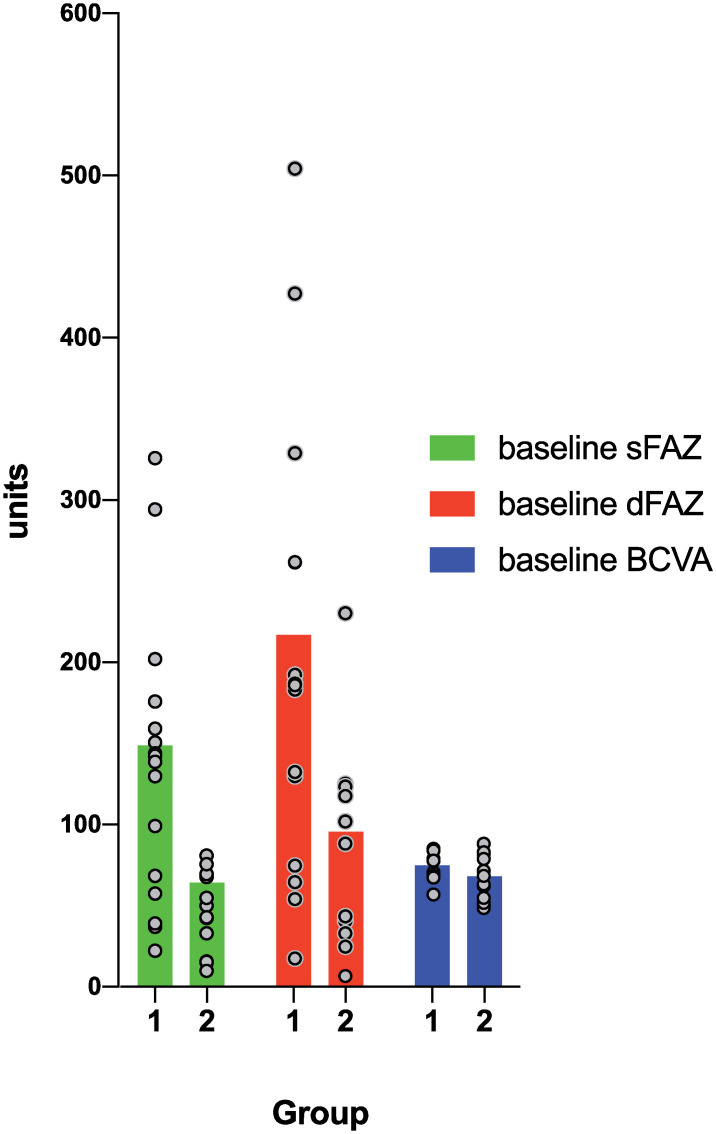
Parameters correlating with ERM severity.Data shows mean baseline sFAZ area, dFAZ area, BCVA, which show significant correlations with ERM severity (Group 1 = ERM stages 1 and 2; Group 2 = ERM stages 3 and 4). The y-axis units refer to the appropriate measures of the before-mentioned variables (sFAZ and dFAZ area: μm2, BCVA: ETDRS letters). Grey dots represent individual values; note that some lay on top of each other. Data are presented as mean; sFAZ = superficial retinal plexus area; dFAZ = deep retinal plexus area; BCVA = best corrected visual acuity.